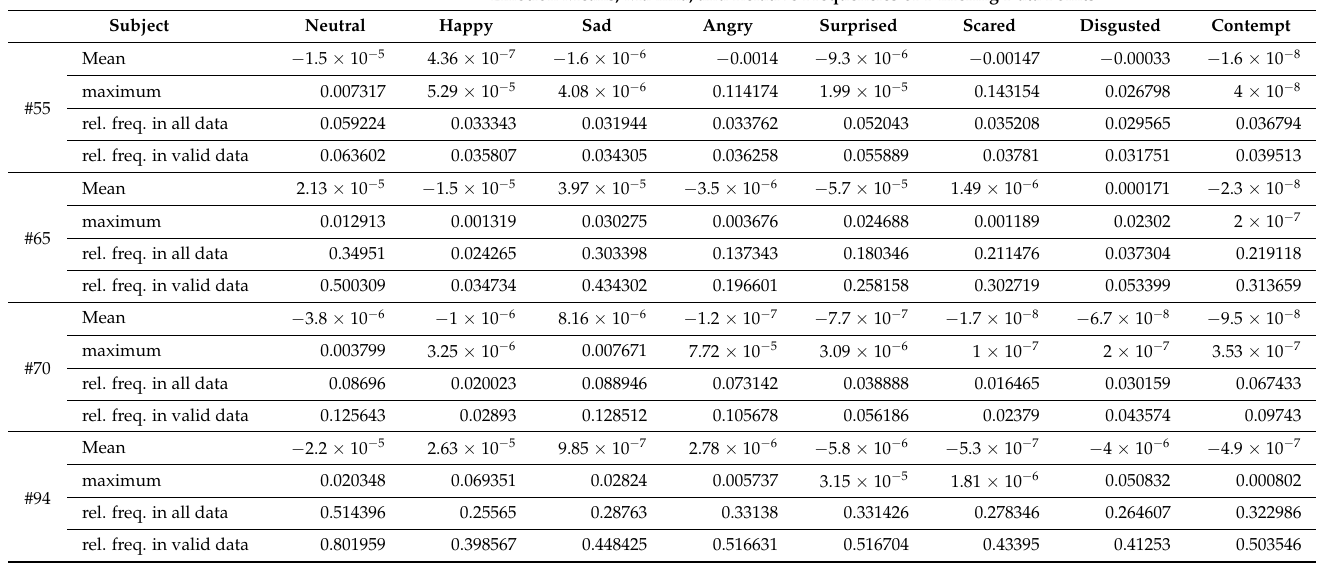
Table A6. Cont . Emotion Means, Maxima, and Relative Frequencies of Differing Data